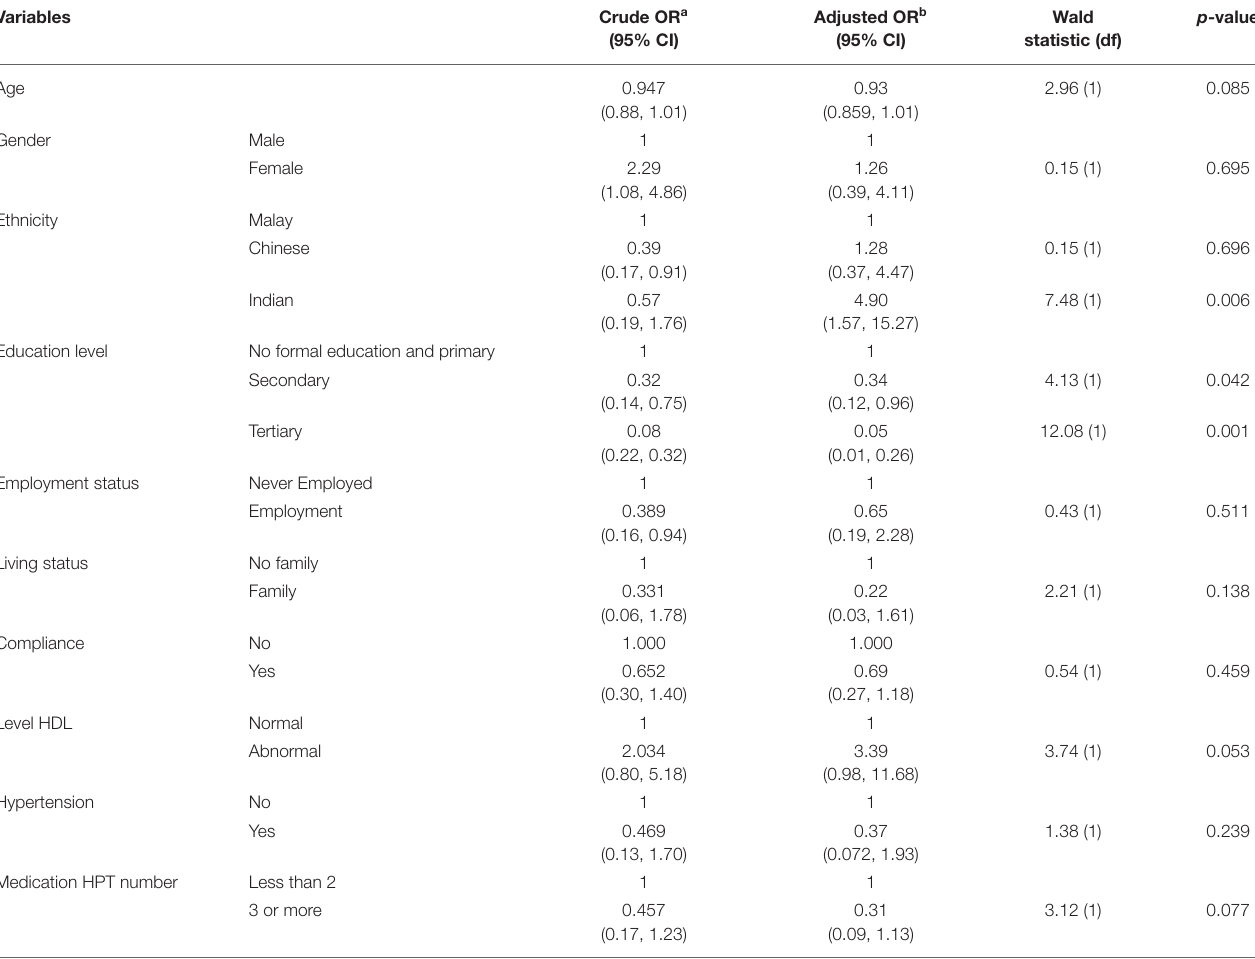
TABLE 4 | Factors associated with cognitive impairment in the elderly with T2DM using logistic regression ( N = 113).